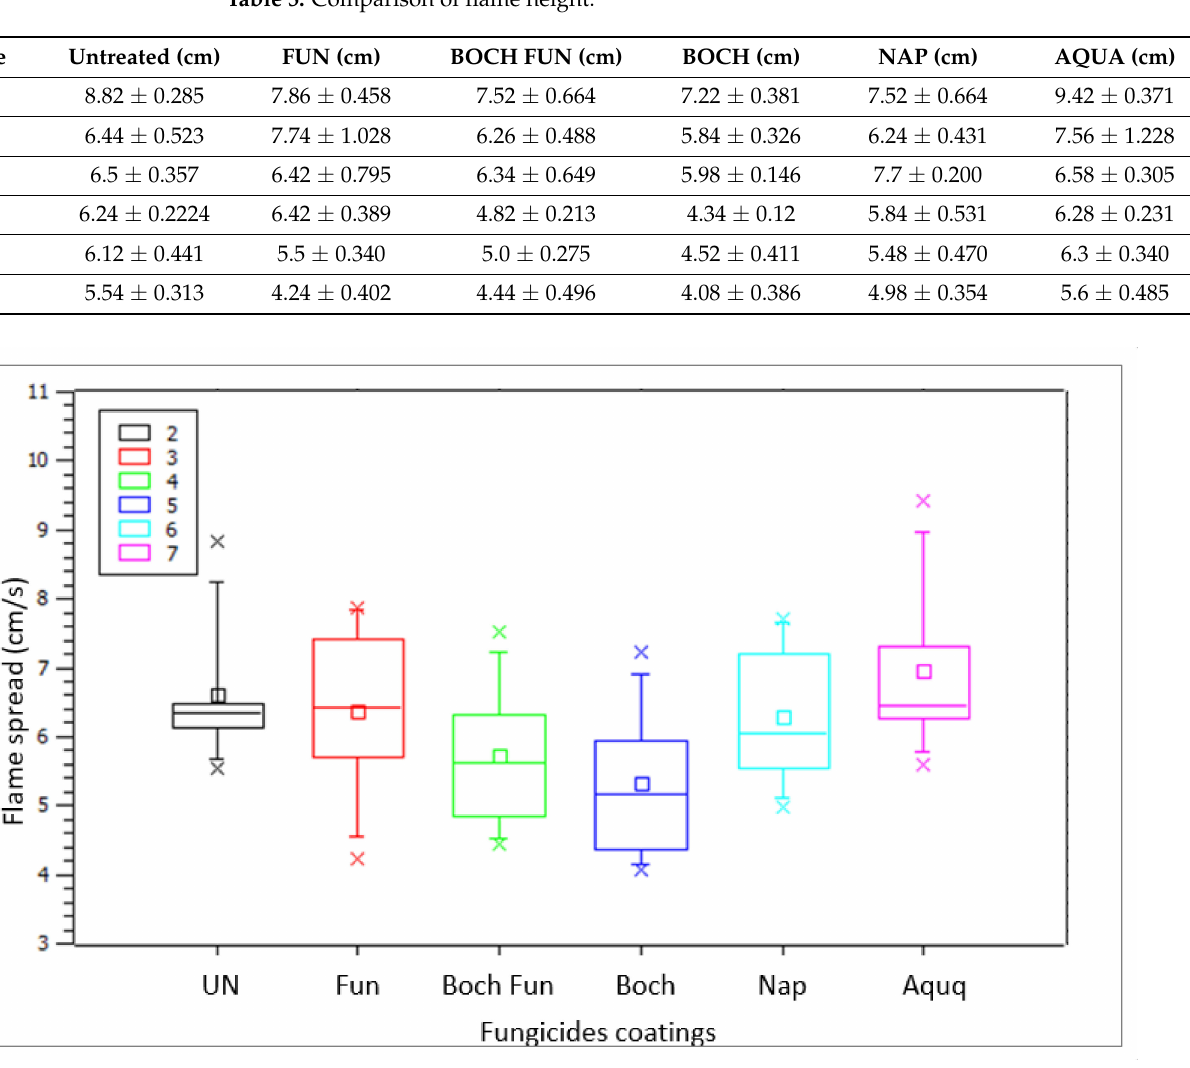
Figure 8. Boxplot to compare the flame spread for each fungicide coating. Legend: UN—untreated with fungicide coating, 2—untreated with fungicide coating, 3—Fun (red), 4—Boch Fun (green), 5—Boch (dark blue), 6—Nap (light blue), 7—Aqua